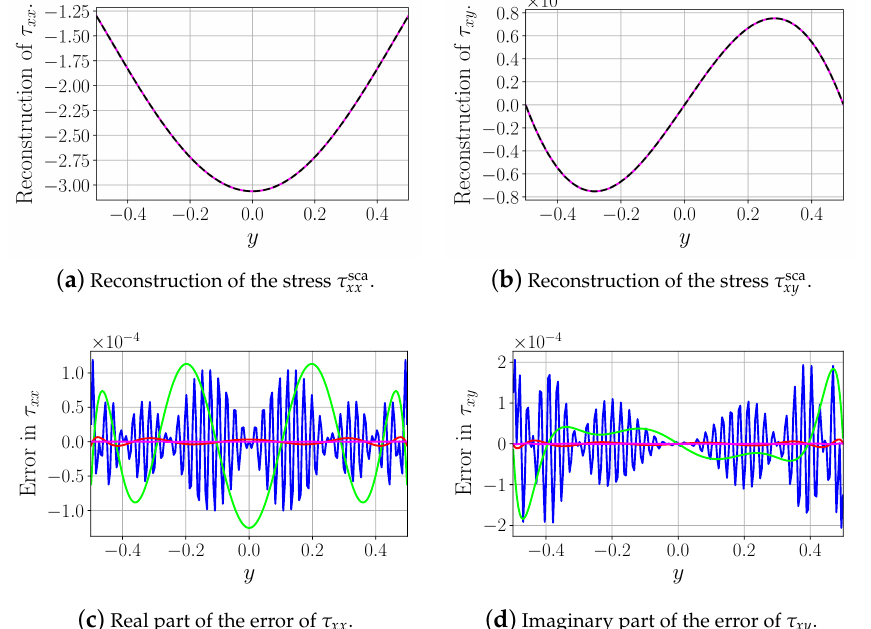
Figure 7. The reconstructions of the stress fields using N symmetric Lamb modes and M corner modes. The curves correspond to: an expansion containing only Lamb waves, with N = 80 ( ); a mixed expansion with N = 2 and M = 4 ( ); an expansion with N = 2 and M = 8 ( ); and an expansion with N = 2 and M = 12 ( ). Subfigures ( a , b ) are the reconstructions of the scattered stress fields along the traction-free face. The negative of the incoming stress fields, which should lie on the same line, are plotted as ( ) for comparison. Subfigures ( c , d ) show the errors of the reconstructions of the total stress fields (sum of the incoming field and the outgoing field). In this example, k t = 4 and ν = 0.3.